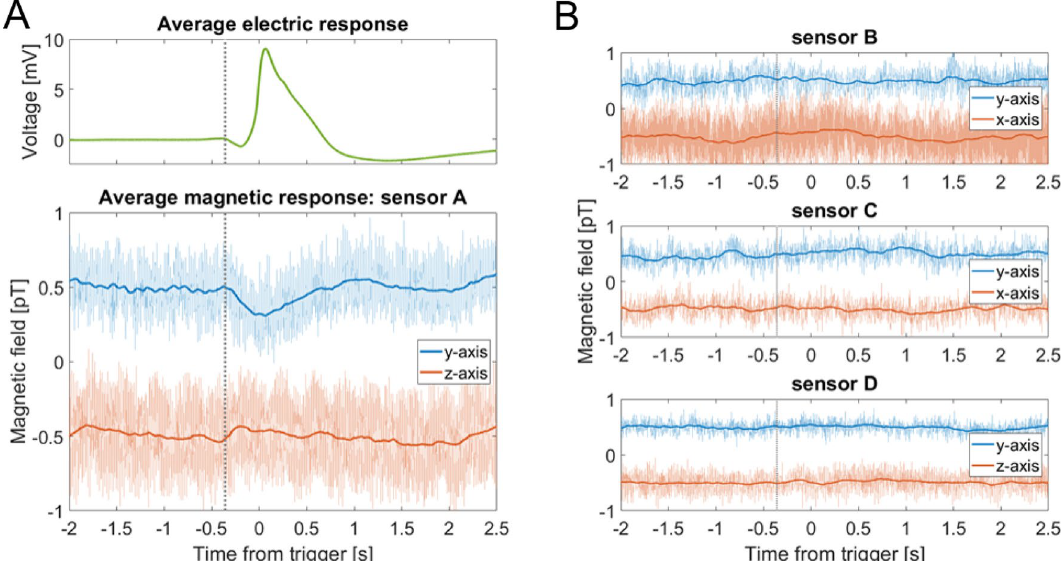
Figure 4. Average action potential and corresponding magnetic signals. ( A ) Result of triggering on nine consecutive APs from a trap lobe heated to 41 °C, then averaging the electric and magnetic data from a 4.5 s window around each trigger point. The average magnetic traces (bottom graph, opaque traces) were frequency-filtered (50 Hz low-pass), then smoothed with a 0.2 s running average. A magnetic signal is visible in both sensitive axes of the primary sensor A. For comparison, the raw unfiltered data are plotted behind the processed data. For visual clarity, DC offsets have been added to the data, and vertical gray dotted lines indicate the approximate start time of the electric signal. ( B ) Average magnetic response from the other three sensors, obtained using the same procedure as in ( A ). The data from the secondary sensors, B and C, do not show a signal. The data from the background sensor D can be used to remove noise common to all sensors (see Fig.